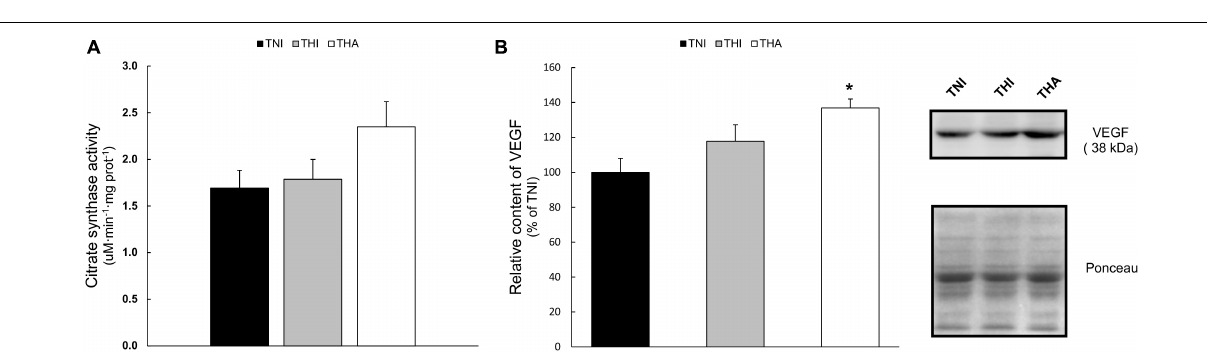
FIGURE 7 | Effects of IHH and IHH+LAE on (A) the biomarker of mitochondrial content citrate synthase activity and (B) the relative content of the pro-angiogenic factor VEGF in TA muscle homogenates. Band’s intensity were normalized to the Ponceau staining and then relativized to the TNI group. ∗ indicates P < 0.05 compared to TNI